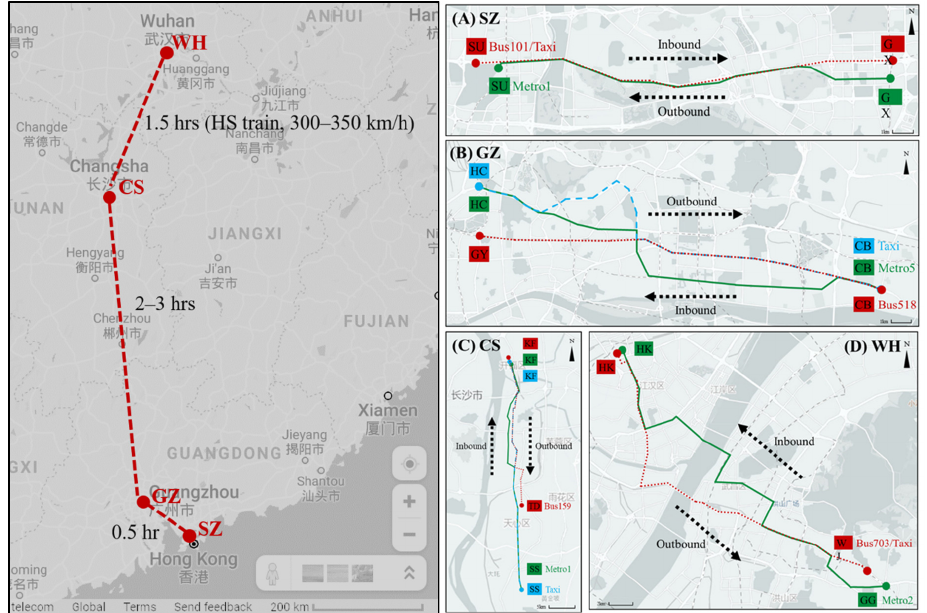
Figure 1. Locations of the four megacities ( left panel ) and respective survey routes ( right panel ). ( A ) survey routes of bus, metro, and taxi in SZ; ( B ) survey routes of bus, metro, and taxi in GZ; ( C ) survey routes of bus, metro, and taxi in CS; and ( D ) survey routes of bus, metro, and taxi in